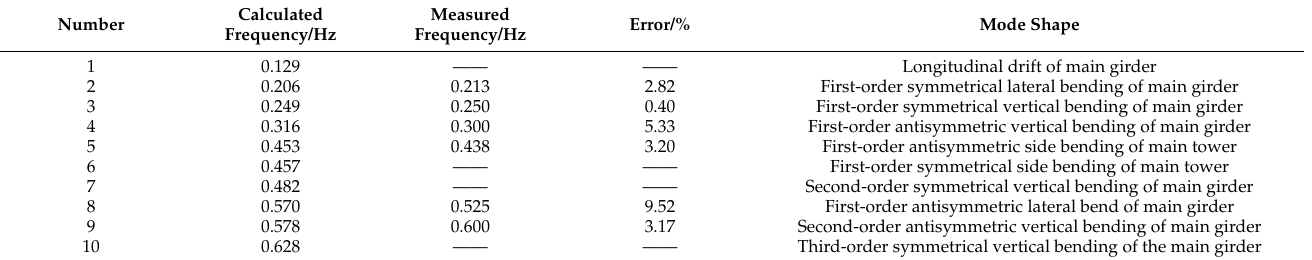
Table 2. Dynamic characteristics of Xiangshan Harbor cable ‐ stayed bridge.